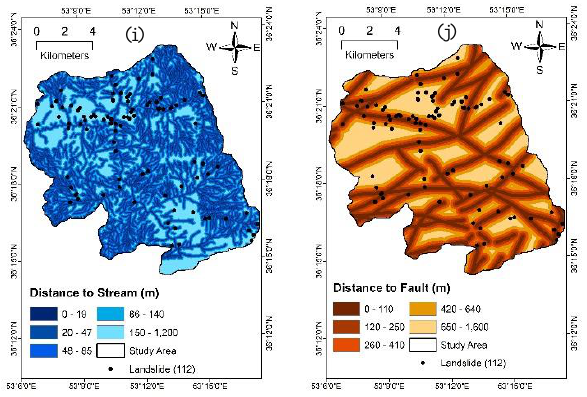
Figure 3. Conditioning factors.